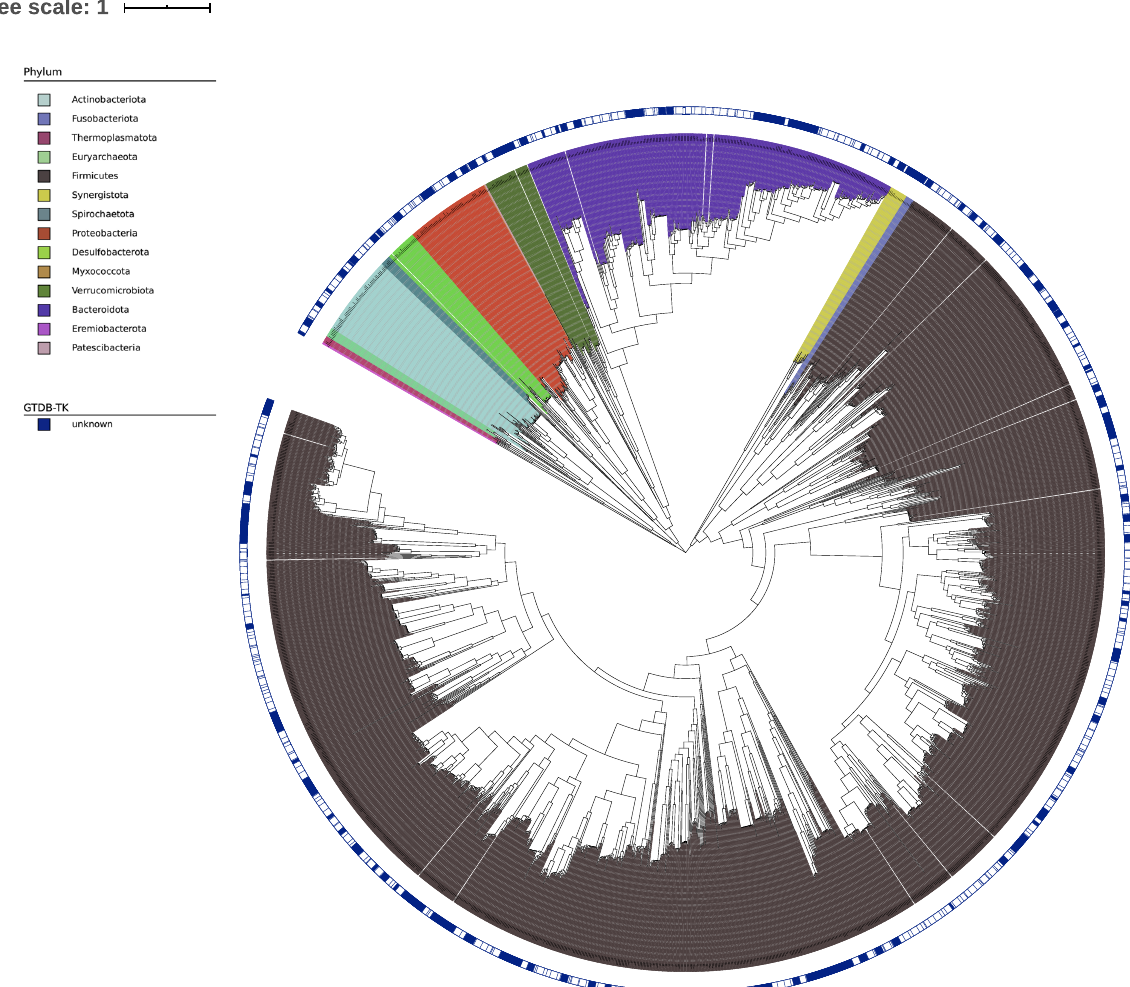
Fig. 1 Phylogenetic tree of the gut microbial genome in Hainan longevity cohort. The phylogenetic tree was constructed using 2,421 MAGs. The MAGs were cataloged using GTDB-TK and indicated by different colors. The peripheral blue circle indicates MAGs that cannot be recognized by